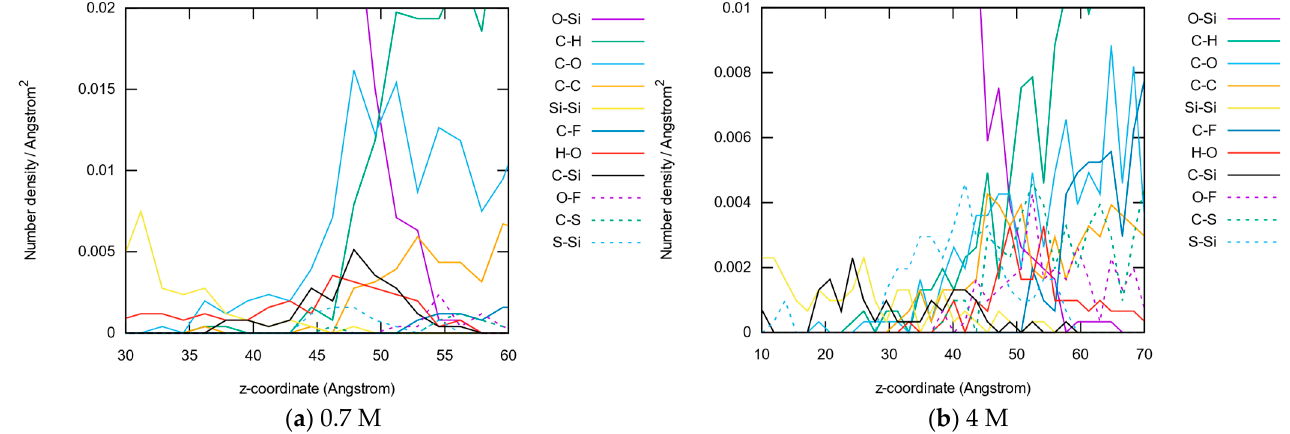
Figure 9. Bond spatial densities along the z -axis for the last time step of both simulated systems, zoomed into the SEI buildup regions for 0.7 M LiTFSI ( a ) and 4 M LiTFSI ( b ). zoomed into the SEI buildup regions for 0.7 M LiTFSI ( a ) and 4 M LiTFSI ( b